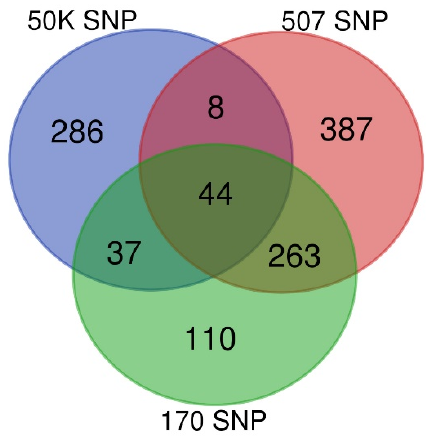
Figure 1. Number of individuals genotyped with 170, 507 and 50K SNPs.